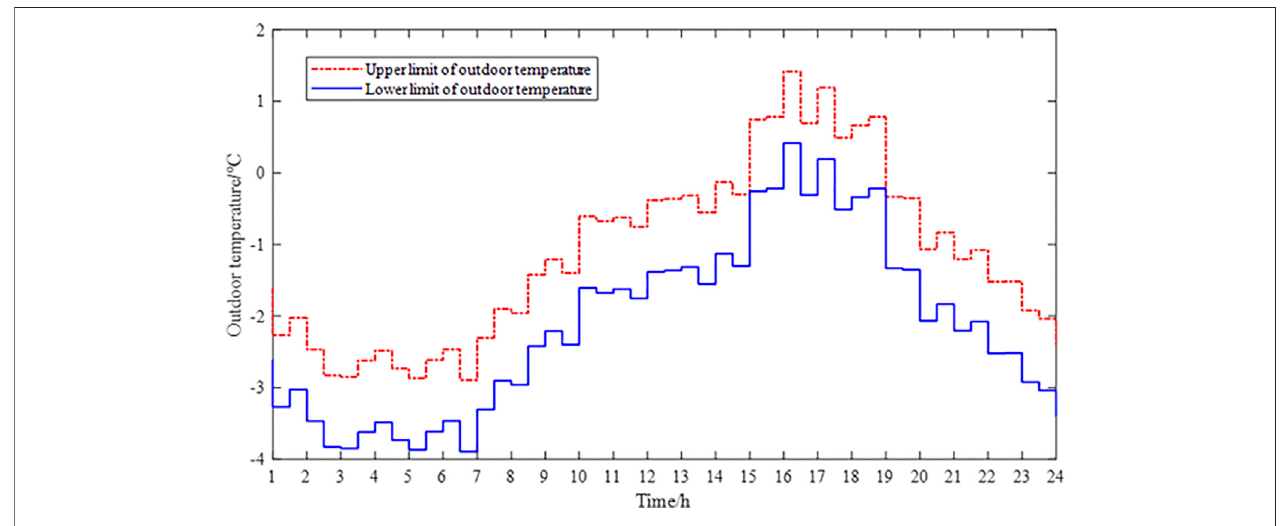
FIGURE 6 | Outdoor temperature prediction interval.